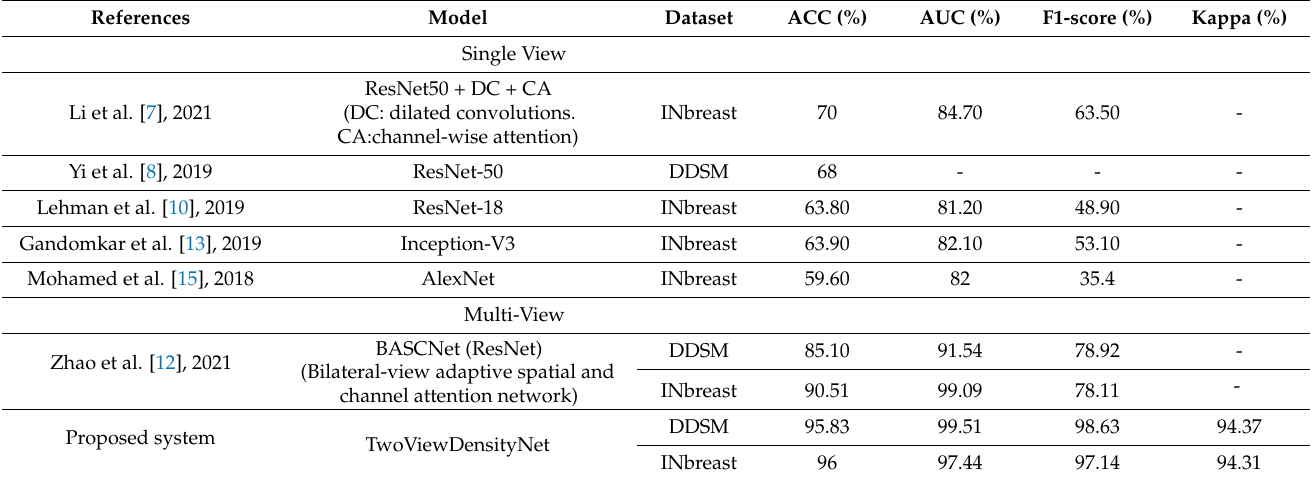
Table 8. The comparison with different state-of-the-art methods for breast density